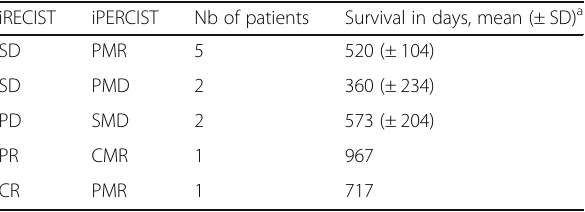
Table 4 Differences between iRECIST and iPERCIST classification, observed in 11/28 patients, in relation to survival iRECIST iPERCIST Nb of